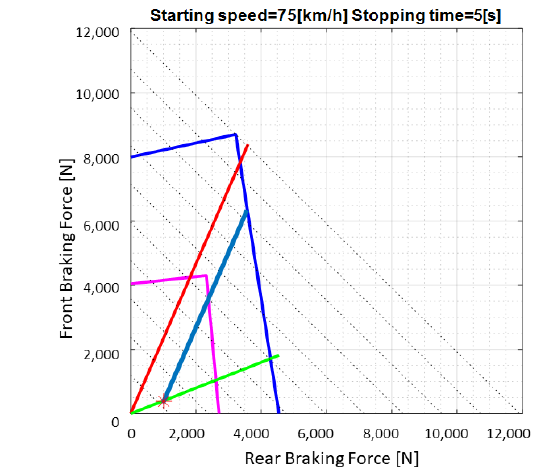
Figure 15. Braking distance versus stopping time, at various starting speeds. Black points indicate the conditions of best energy recovery. In Figure 16 an overall view of all the results, in terms of percent of vehicle kinetic energy recovered, is presented, as a function of the starting speed and the stopping time. The iso-level curves for the recovered energy are also plotted. This graph has been ob- tained by modulating the braking manoeuvre in 8 steps. The set of results refers to vehi- cles whose features are summarized in Table 1, considering a maximum recoverable power equal to 20 kW. In this case, the maximum percent of the vehicle kinetic energy that can be recovered to the battery is about 40%. The red dotted line approximates the best conditions for each speed (Figure 17). It can be observed that there is an almost linear relationship between the best stopping time and the starting speed. The best conditions correspond to a deceleration ranging from 2.7 to 3.7 km/h per second, as shown in Figure 18, while in Figure 19, the optimal braking distance for each starting speed is presented. This is useful for possible application in a real-time control framework in determining the best braking intensity for a given starting speed to achieve the maximum energy recovery.